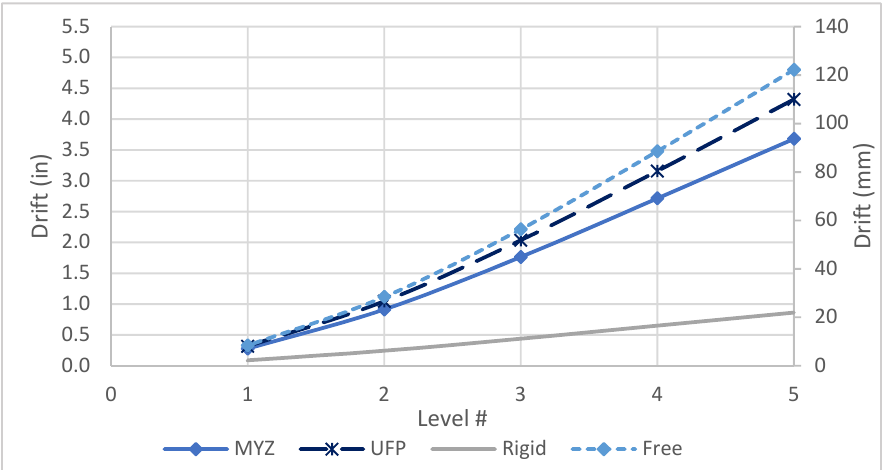
Figure 20. Building and floor drifts for all models.